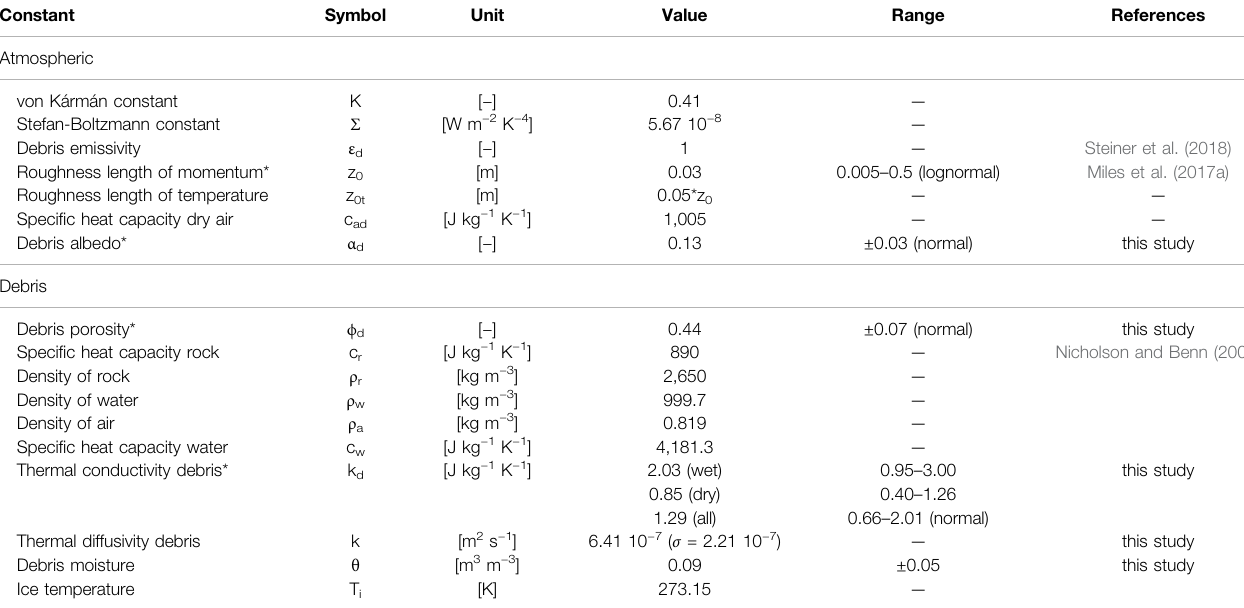
TABLE 2 | Constants used in the study and the range used for the uncertainty analysis.